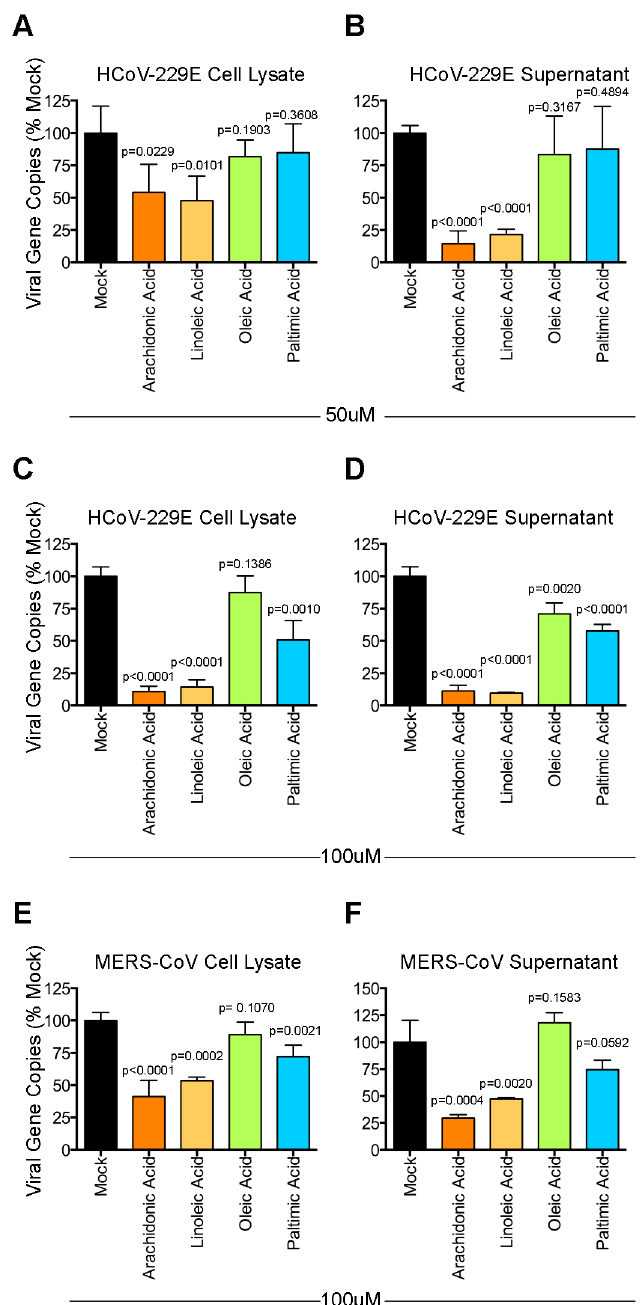
Figure 6. Modulatory effect of lipids on HCoV-229E and Middle East respiratory syndrome coronavirus (MERS-CoV). Huh-7 cells were infected with HCoV-229E. After 1 h of inoculation, the virus inoculum was replaced with medium containing 50 µ M ( A , B ) or 100 μ M ( C , D ) of lipids and incubated for 24 h. The supernatants and cell lysates were collected for reverse-transcription quantitative polymerase chain reaction (RT-qPCR) analysis. In parallel, Huh-7 cells were infected with MERS-CoV. After 1 h of inoculation, the virus inoculum was replaced with medium containing 100 μ M ( E , F ) of lipids and incubated for 24 h. The supernatants and cell lysates were collected for RT-qPCR analysis. Statistical significance was determined by Student’s t-test by comparing the individual lipid-treated group with the mock-treated group ( n = 4). The difference was considered significant when p < 0.05.